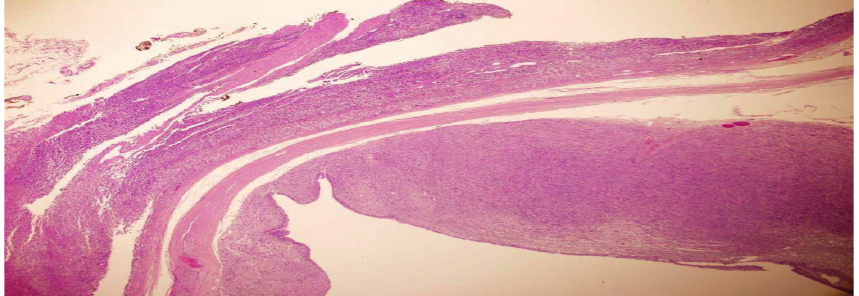
Figure 2: Low-power view of the adrenal gland (top) and schwannoma with capsule (middle) and cystic change (bottom). H&E × 40.